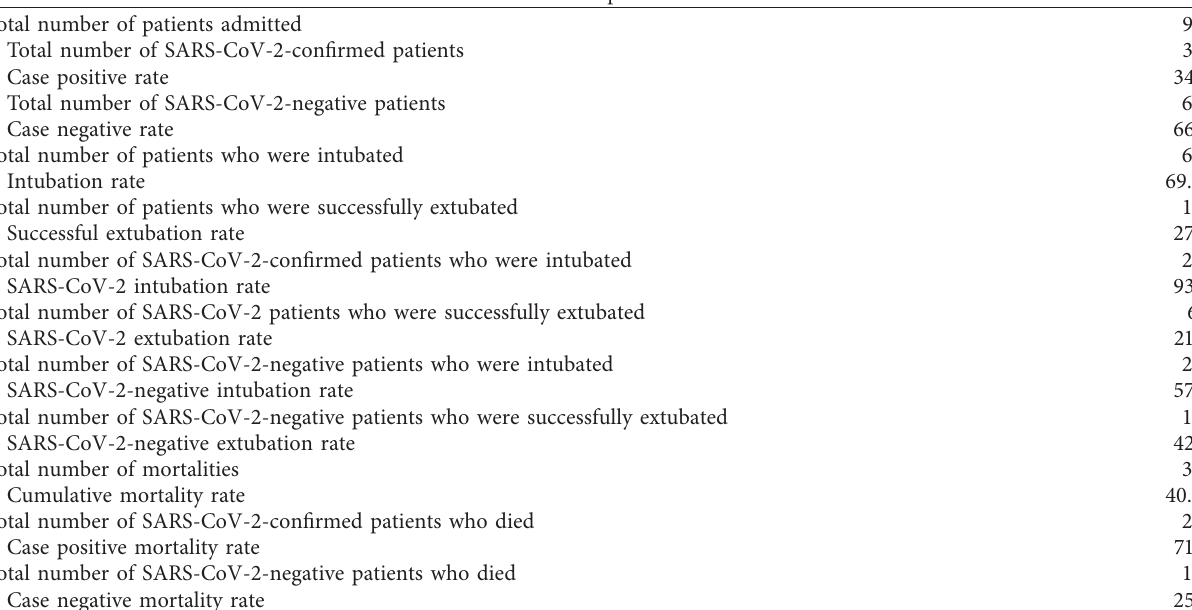
Table 1: Descriptive